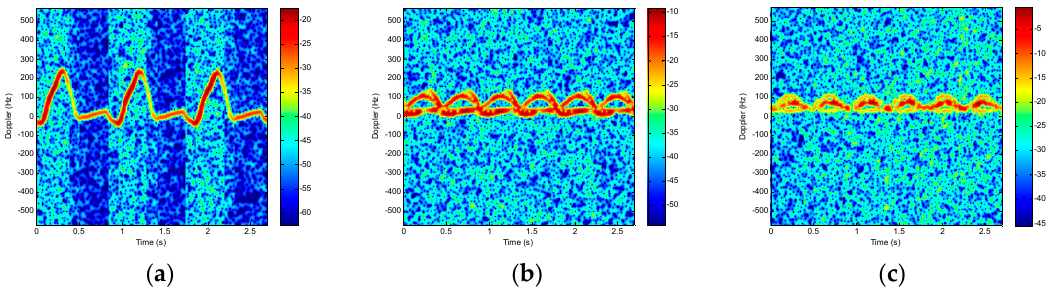
Figure 11. Decomposition results of the HHT: ( a – c ) TFD of IMF1–IMF3.